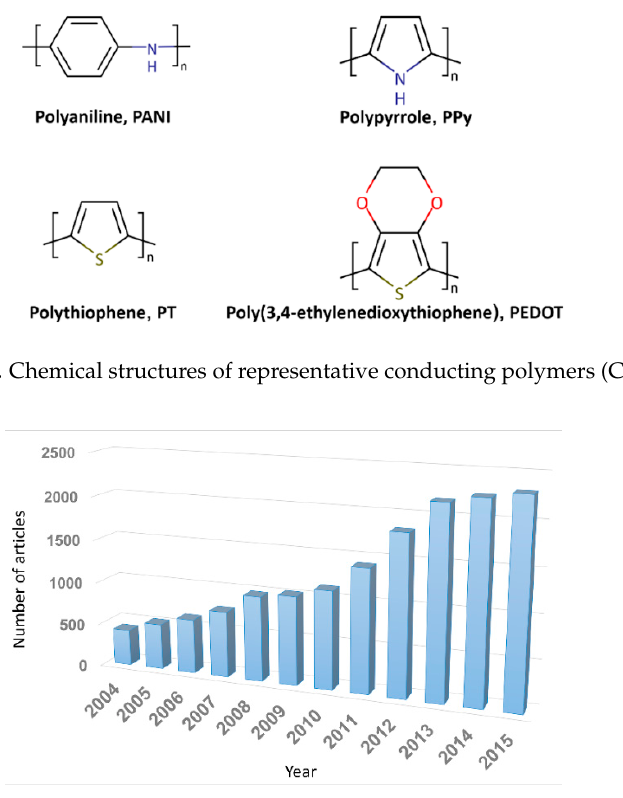
Figure 2. The number of articles published on CP nanomaterials over the last decade. Data from the ISI Web of Knowledge database.